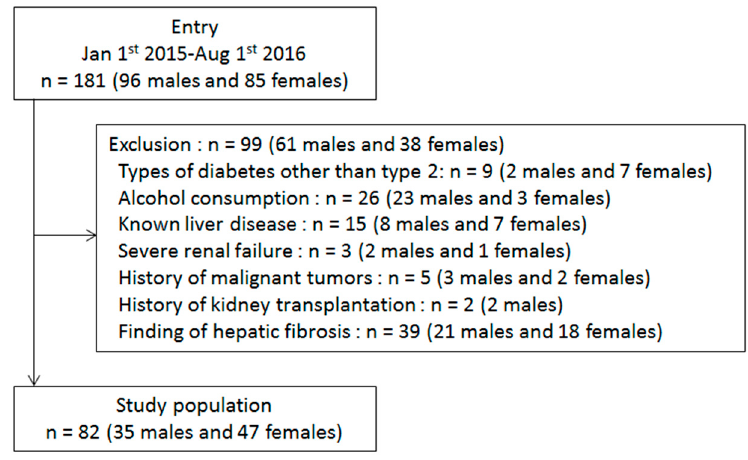
Figure 1. The study flow diagram.